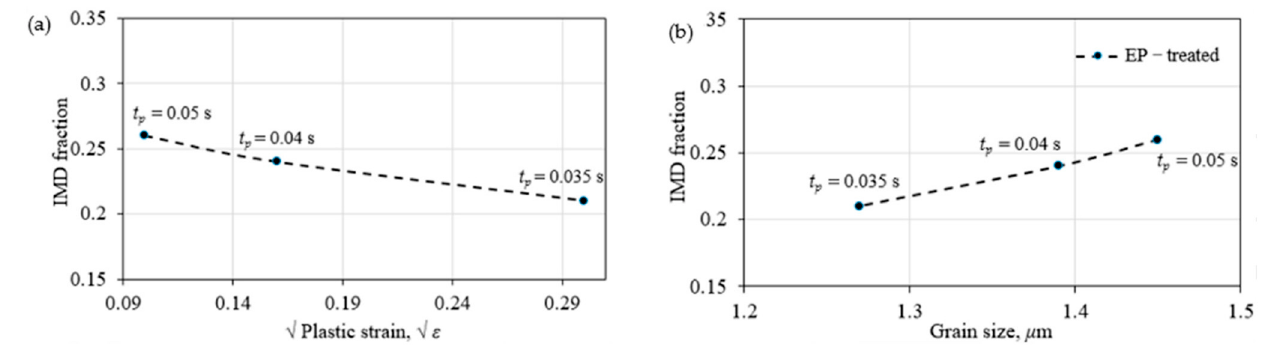
Figure 14. IMD evolutions against ( a ) strain and ( b ) grain size.